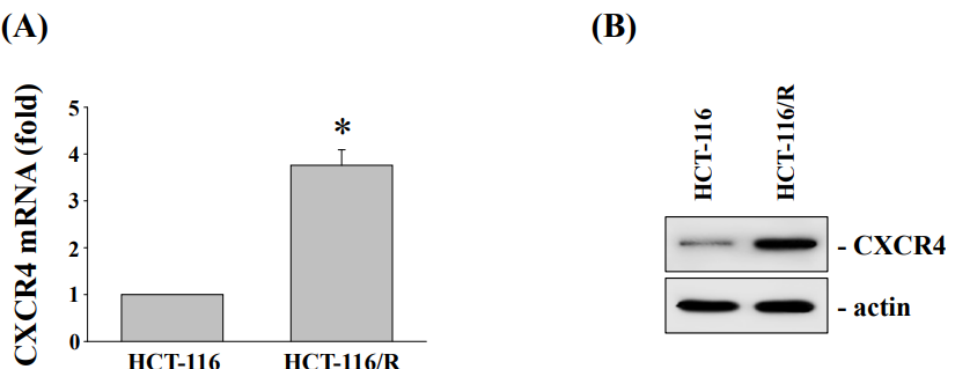
Figure 3. The CXCR4 expression of oxaliplatin-resistant CRC HCT-116/R cells and the parental cell line HCT-116. ( A ) Real-time polymerase chain reaction analysis of CXCR4 mRNA expression in HCT-116 and HCT-116/R cells. ( B ) Western blot analysis for the expression of CXCR4 in HCT-116 and HCT-116/R cells. * p < 0.01 vs. HCT-116/R cells.